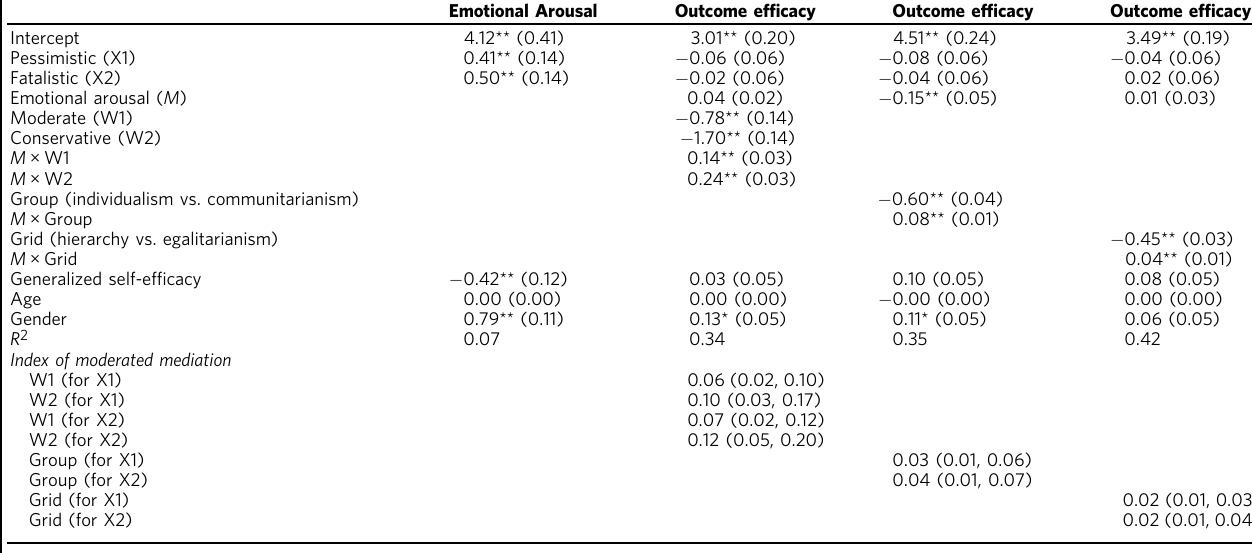
Table 2 Results of conditional process analysis (moderated mediation model), Study